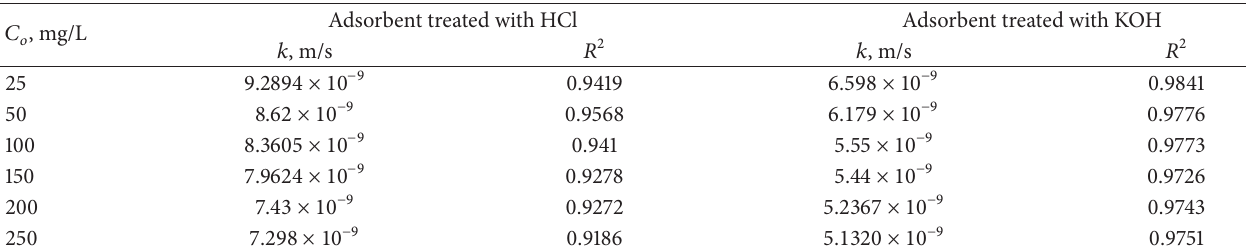
Table 5: The time taken by the adsorbent treated with HCl for the three different stages of adsorption. HCl treated adsorbent, concentration 25 mg/L